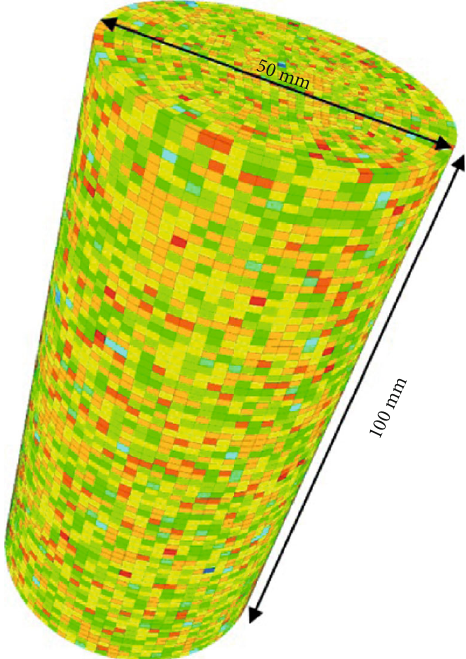
Figure 7: Schematic diagram of Beishan granite